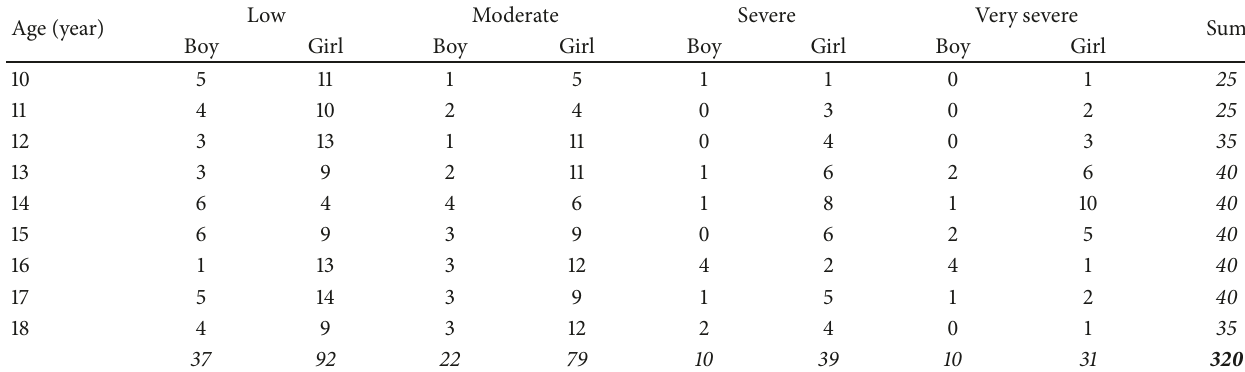
Figure 2: Measured parameters. (a) FM-FS: femoral mechanical axis-femoral shaft angle, FMA: femur mechanical axis, and FAA: femur anatomical axis; (b) FHD: femur head diameter; (c) FNL: femoral neck length; (d) NSA: neck shaft angle (FNA: femur neck axis); (e) FO: Femoral offset; (f) FT: femoral torsion (PCL: posterior condylar line). Table 1: Age and gender distribution of the examined